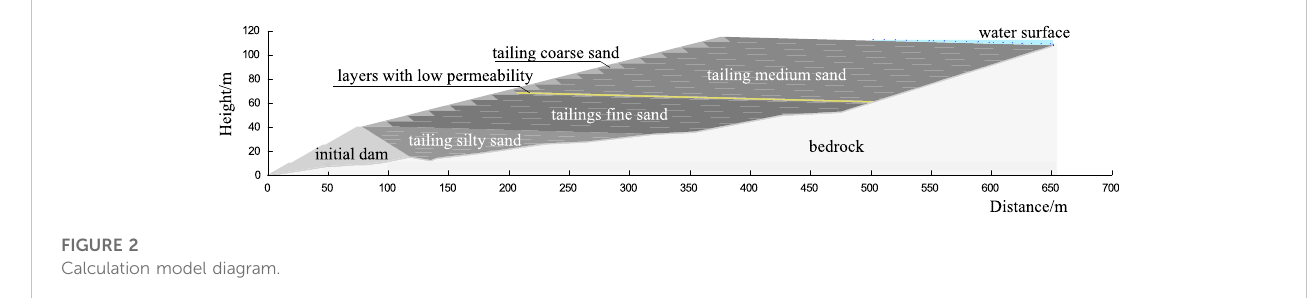
FIGURE 2 Calculation model diagram.